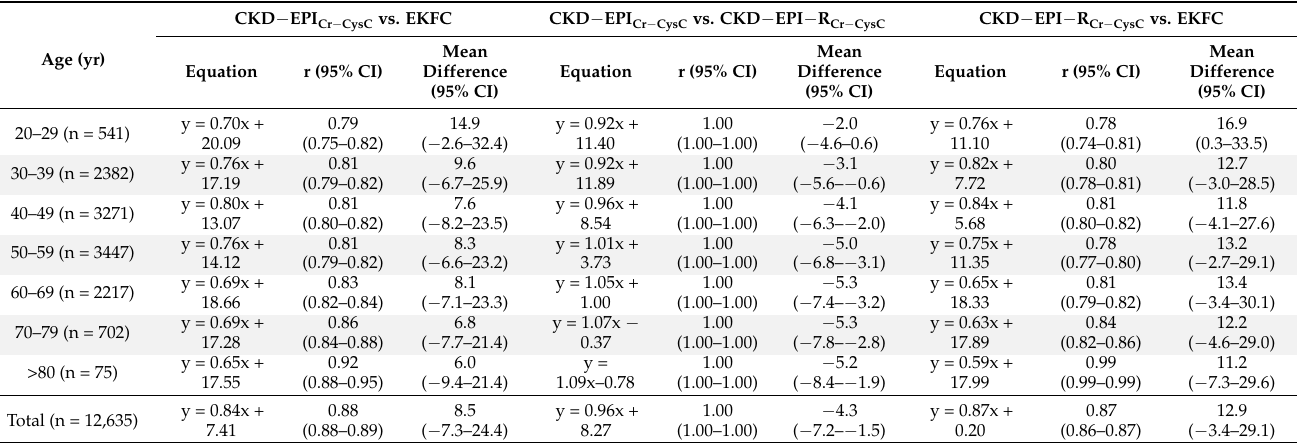
Table 4. Correlation and differences of eGFR among serum creatinine- and cystatin C-based CKD-EPI, EKFC, and CKD-EPI-R equations stratified by age group.